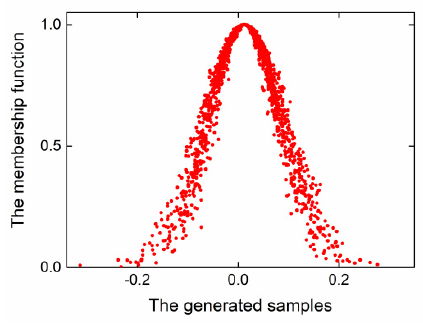
Figure 14. The membership function of the generated samples.